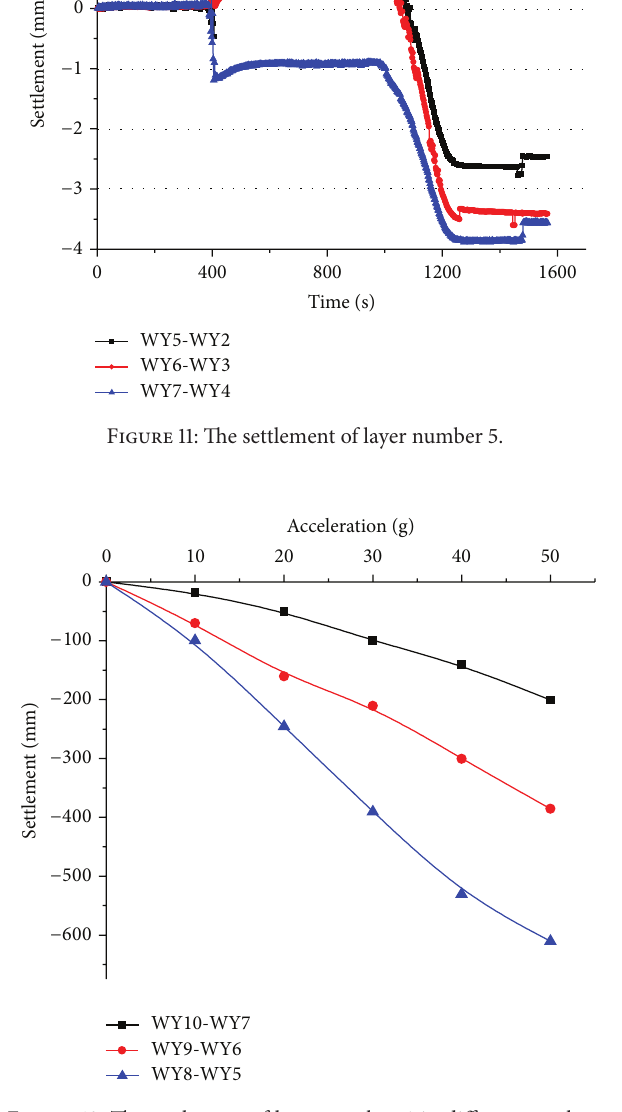
Figure 12: The settlement of layer number 4 in different accelera- tions.